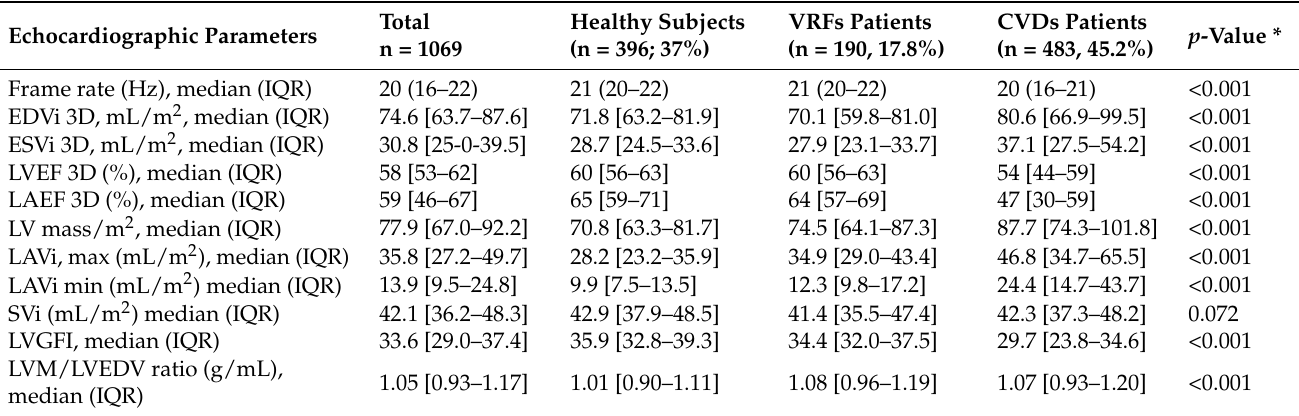
Table 2. Three-dimensional (3D)-DHM echocardiographic metrics stratified according to the presence of VRFs and CVDs.